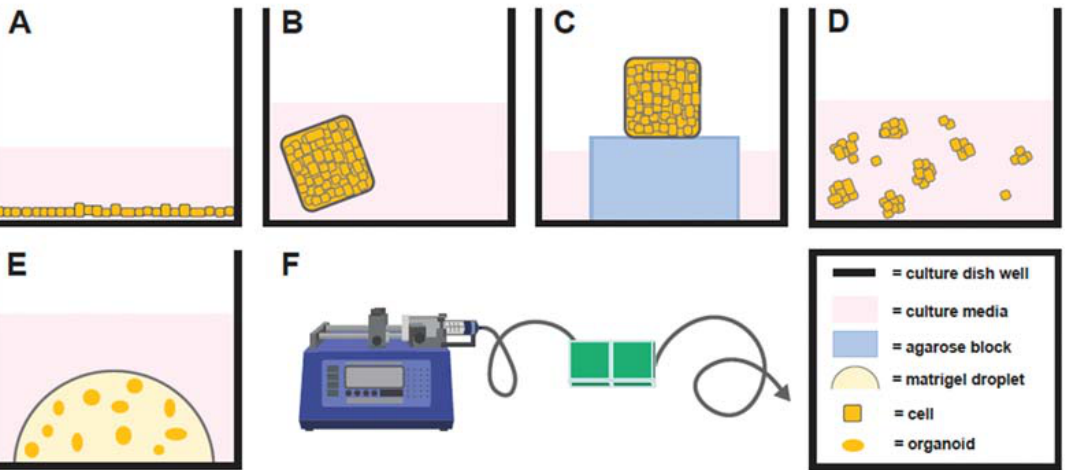
Figure 1. Depiction of monolayer cell culture ( A ), explant immersed in culture media ( B ), explant with a gas–fluid interface ( C ), spheroid cell culture ( D ), organoid cell culture ( E ), and organ-on-a-chip ( F ) with A–E illustrated from a lateral perspective in a single well of a multi-welled culture plate.